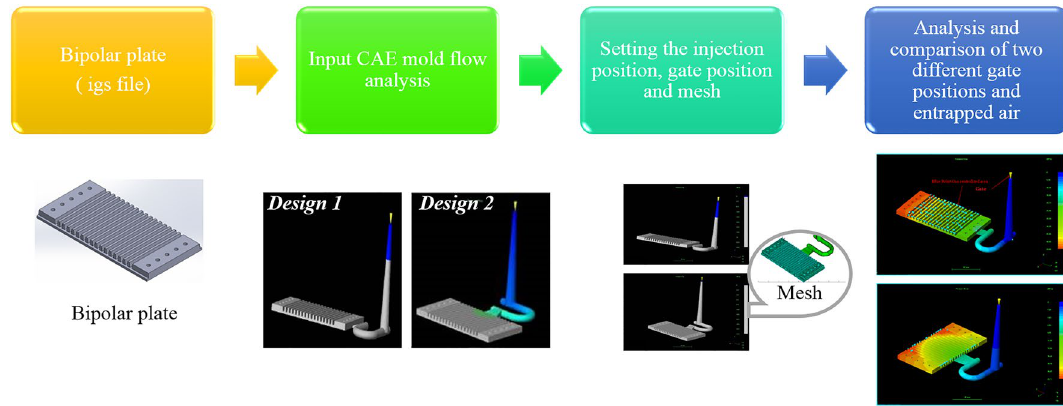
Figure 5. The procedure of CAE mold flow analysis for PMMA bipolar plates with different